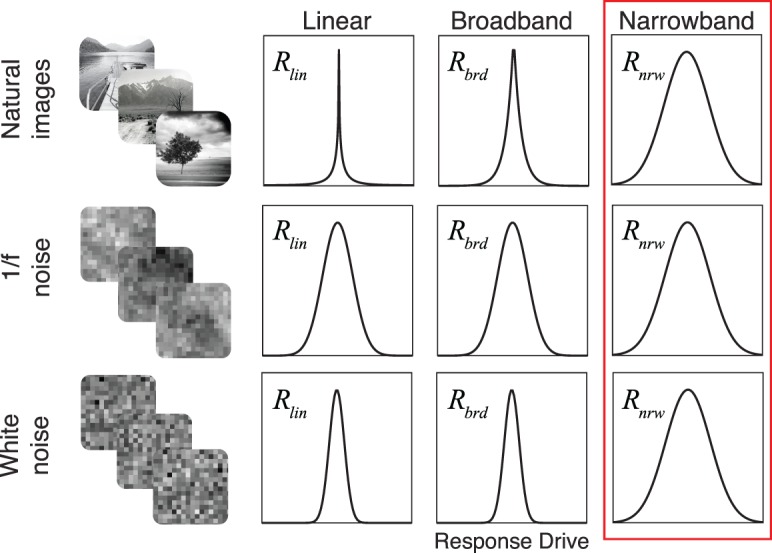
Distributions of linear, broadband-normalized, and narrowband-normalized response drives caused by natural stimuli, 1/f noise stimuli, and white-noise stimuli. Linear responses to natural stimuli are very heavy tailed (i.e., heavier than a Laplace distribution; see Supplementary Figure S1). Broadband responses to natural stimuli are Laplace distributed (see Supplementary Figure S2). Narrowband responses to natural stimuli are Gaussian (see Figures 5 and 8 and Supplementary Figure S3). Linear and broadband responses to 1/f and white noise are guaranteed to be Gaussian, if the number of pixels defining each stimulus (i.e., dimensionality) is sufficiently high. Narrowband responses to noise stimuli are all approximately Gaussian. Narrowband normalization produces responses (i.e., response drives) that are very nearly Gaussian with all three stimulus types. Narrowband normalization helps standardize the distributional form of the response statistics across stimulus types (box). Narrowband normalization should thus improve the ability of computational models of visual information processing to generalize across stimulus types.